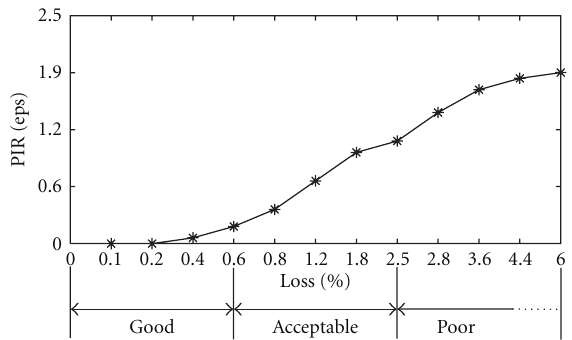
Figure 6: Loss GAP ranges for SD resolution under both PFIFO/ TFIFO.